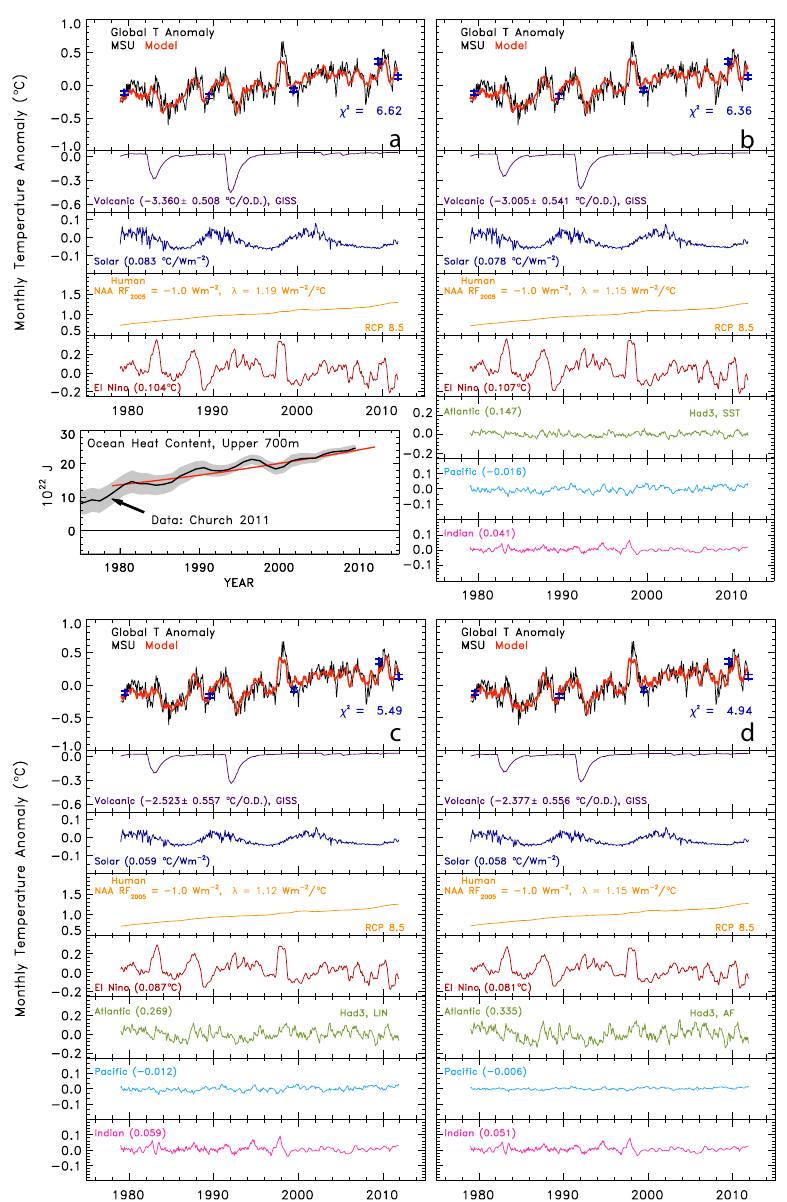
Fig. 13. Same as Fig. 6, but for analysis of the global, monthly mean LT5.4 (lower troposphere) temperature anomaly measured by Microwave Sounding Unit (MSU) instruments. The analysis is from December 1978 to December